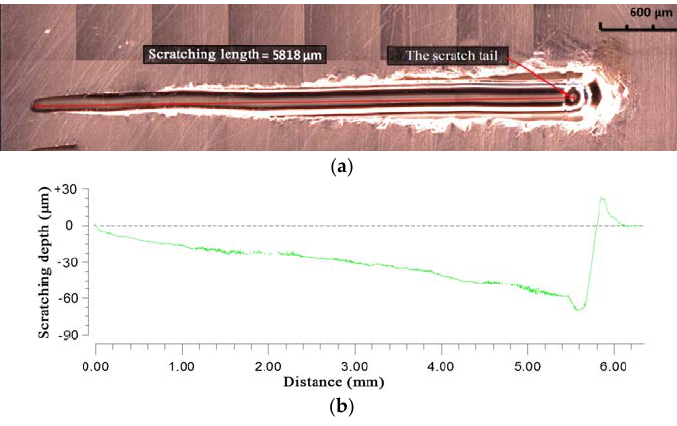
Figure 2. The measurement results of scratching. ( a ) Full picture of the scratch; ( b ) The actual scratching depth of the scratch.